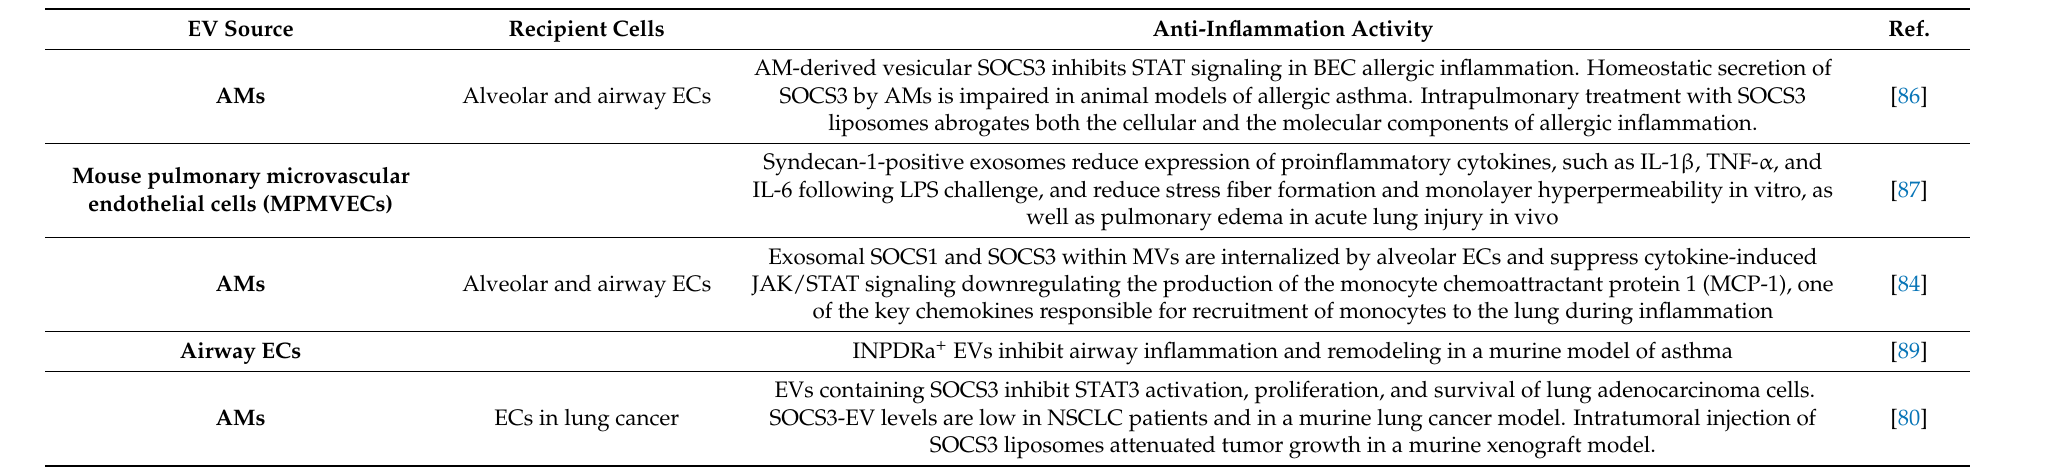
Table 2. Anti-inflammatory effects of EVs in different lung